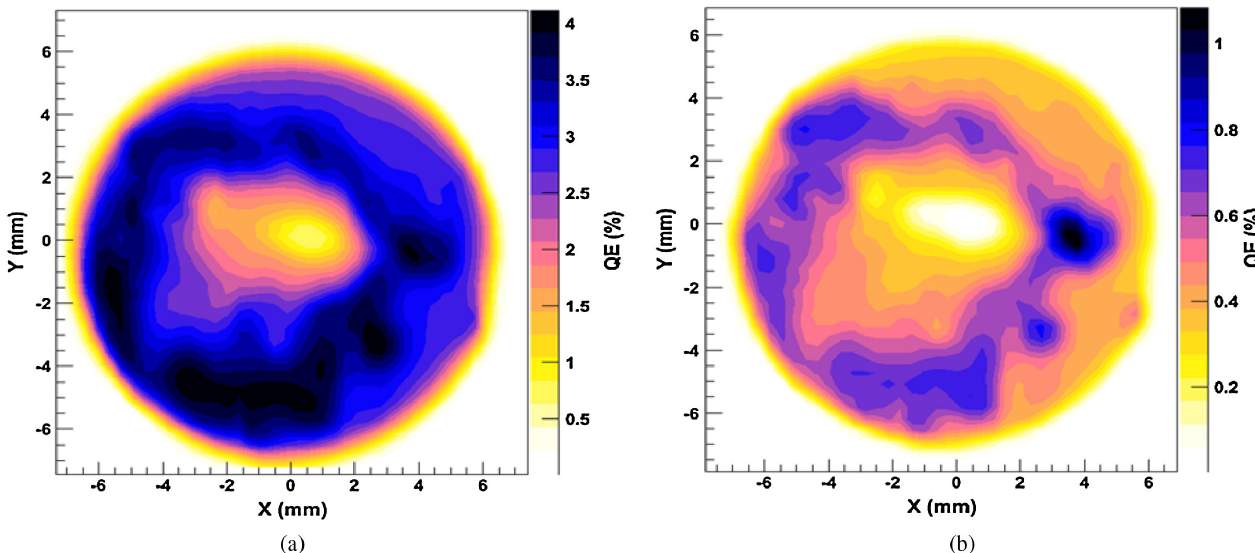
FIG. 8. QE scans following the vacuum event during which greater than 1.5 mA of beam was dumped into a valve for an extended period of time: (a) 440 nm light and (b) 532 nm light. Absence of QE in the wafer center was an indication that photocathode material was sputtered away by ions produced by the extracted beam. Note the high QE spot in (b) at approximate location x=y ¼ 4 , 0 mm was produced after extracting 4 mA over 24 hrs using 440 nm light after the vacuum